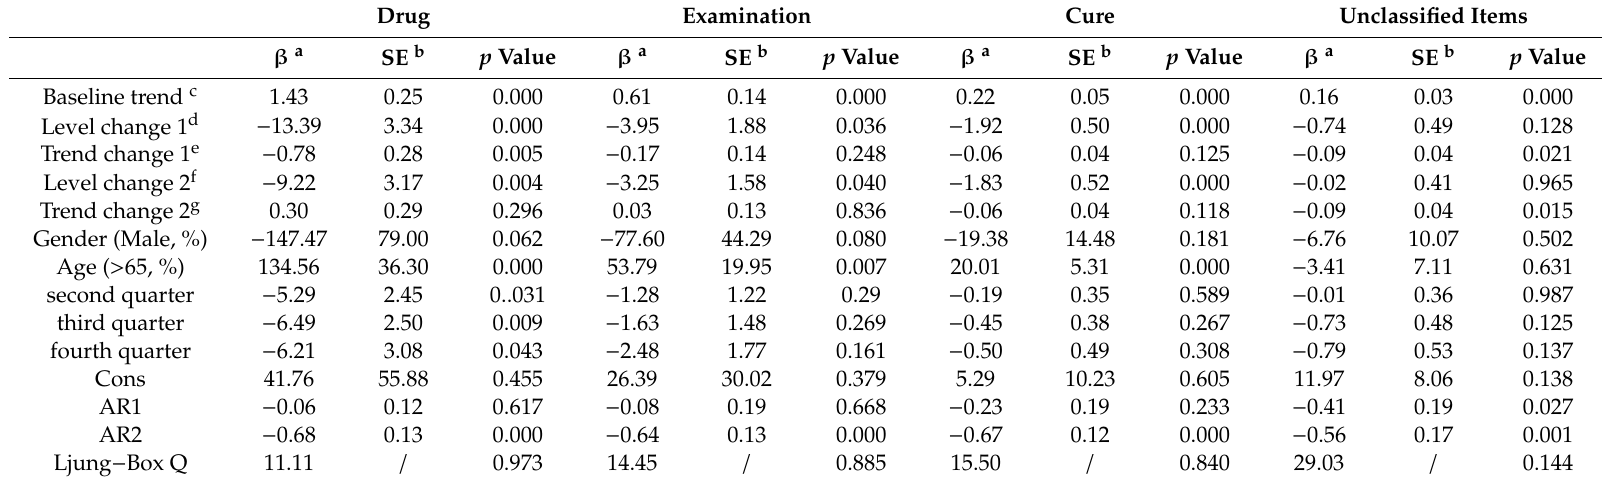
Table A2. Segmented autoregressive integrated moving average analysis of medical expenditure of respiratory disease (Million